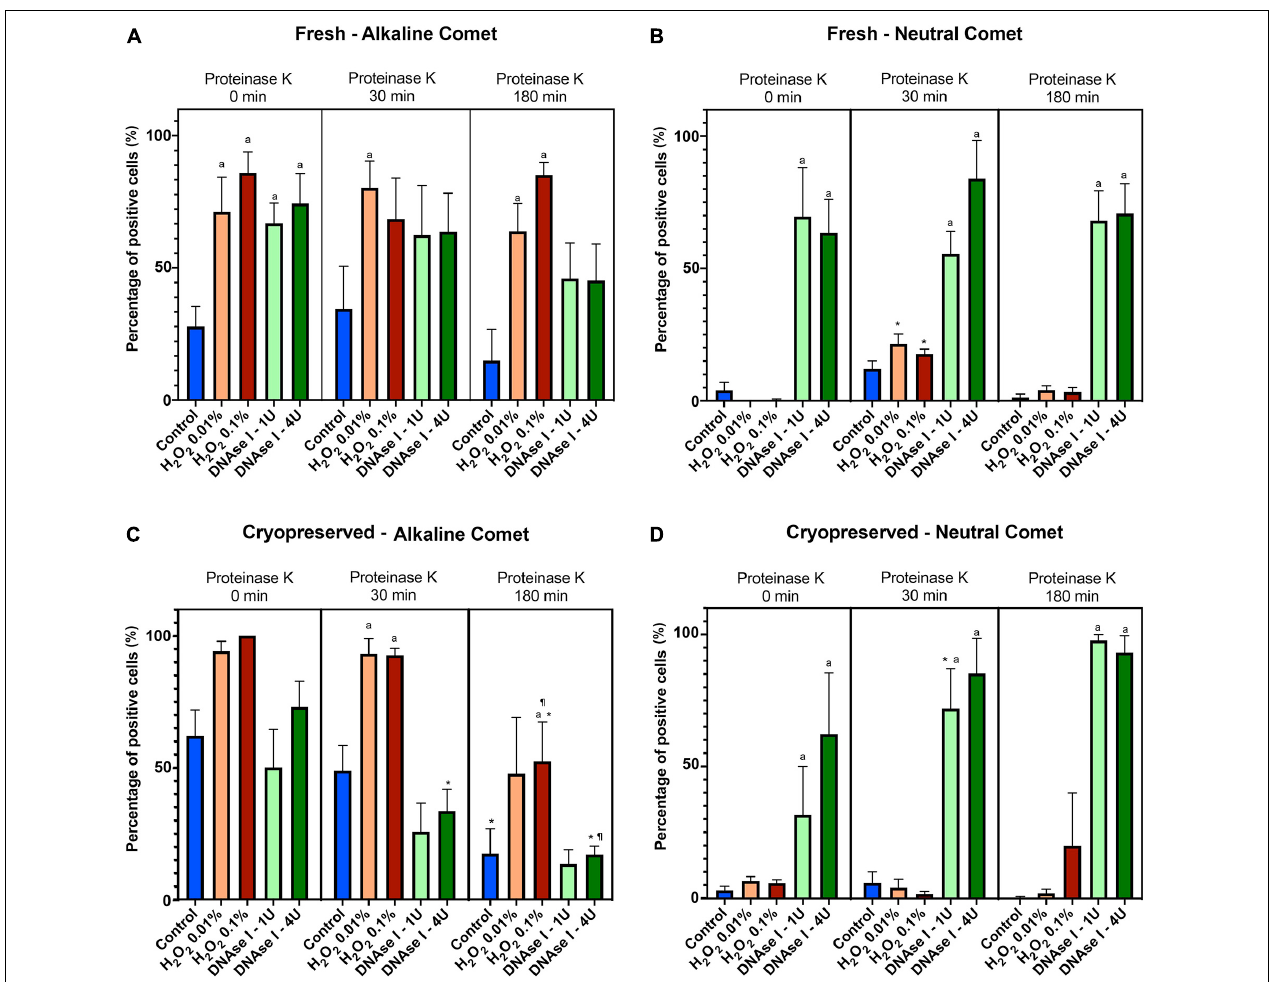
FIGURE 4 | Percentage of sperm DNA fragmentation (% SDF) after different Proteinase K treatments. Panel (A) shows % SDF for alkaline Comet in fresh samples. Panel (B) depicts % SDF for neutral Comet in fresh samples. Panel (C) shows % SDF for alkaline Comet in cryopreserved samples. Panel (D) depicts % SDF for neutral Comet in cryopreserved samples. (*) Statistical differences compared to the similar treatment in 0 min of proteinase K ( P < 0.05). (¶) Statistical differences compared to the similar treatment in 30 min of proteinase K ( P < 0.05). (a) Statistical differences compared to the control of the same proteinase K treatment ( P < 0.05).